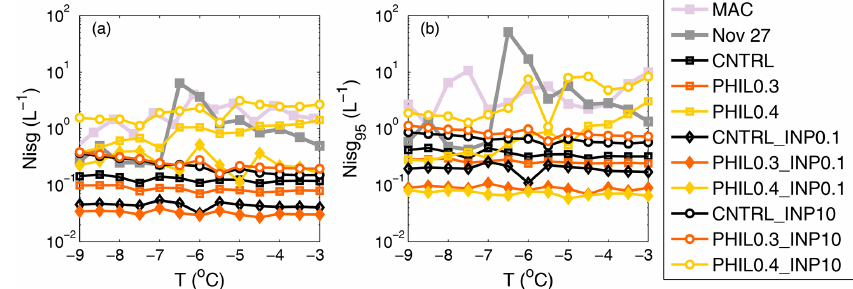
Figure 6. Same as in Fig. 5 but for sensitivity simulations with varying INP conditions (see Sect.